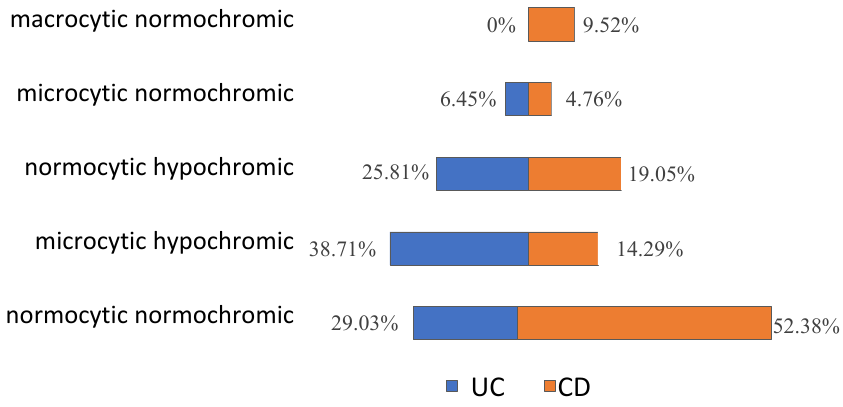
Figure 2. The prevalence of particular types of anaemia in patients with ulcerative colitis (UC) and Crohn’s disease (CD).